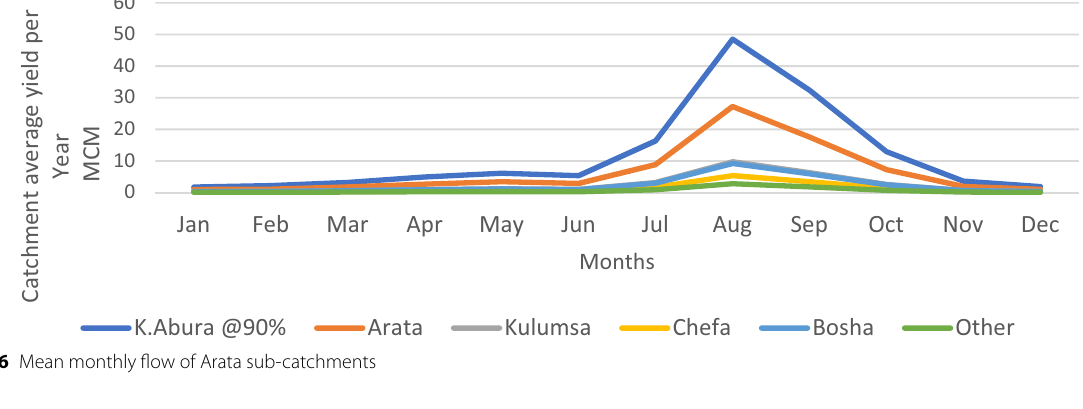
Fig. 6 Mean monthly flow of Arata sub-catchments